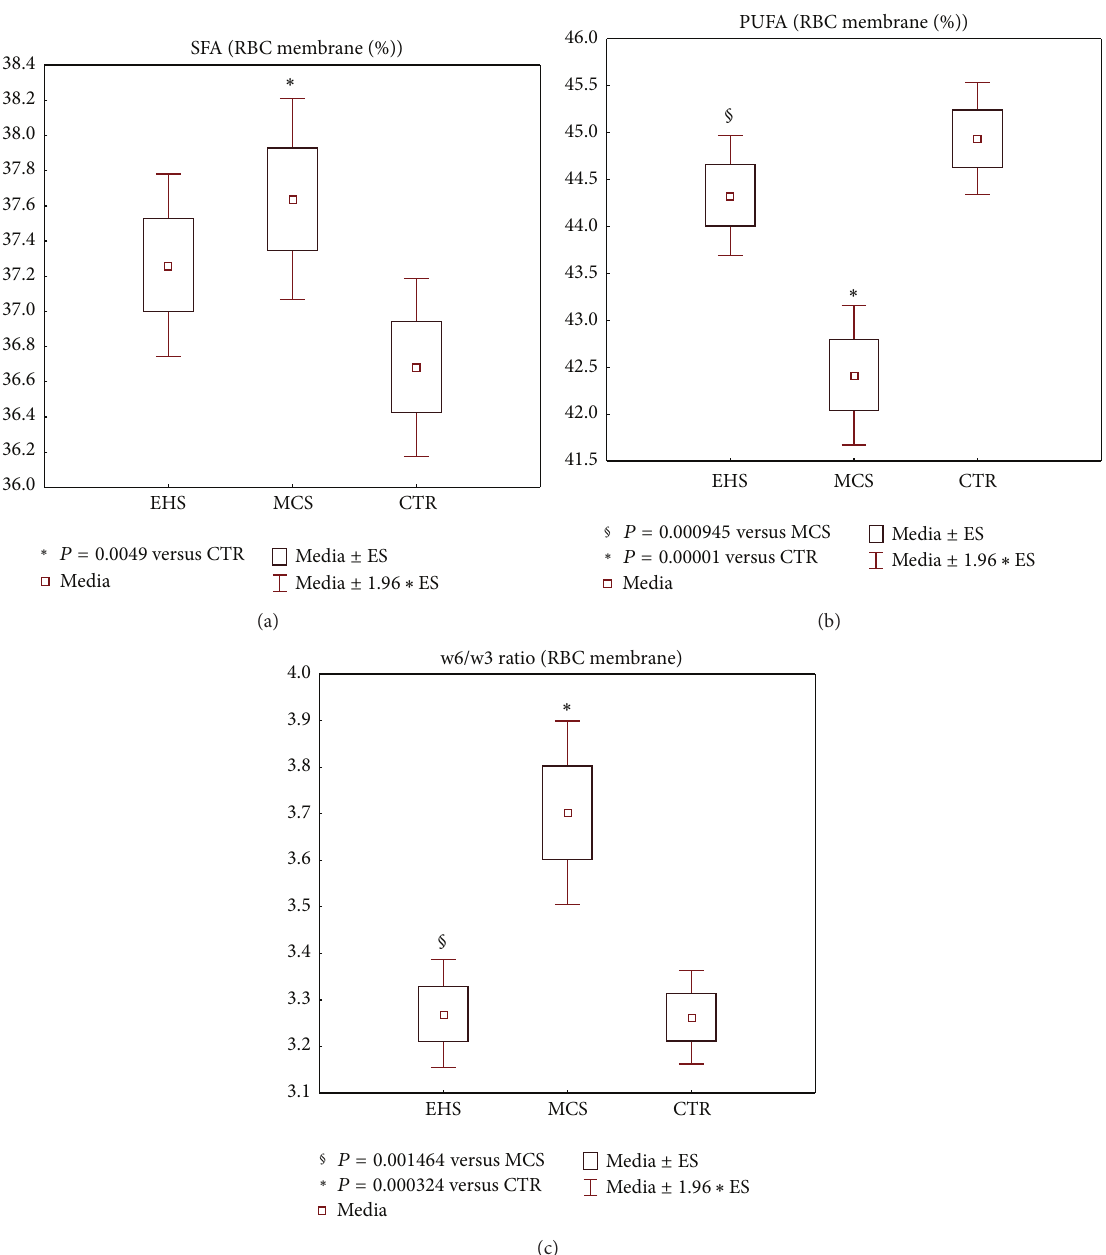
Figure 7: Selected representative parameters describing fatty acid (FA) patterns of erythrocyte membrane phospholipids, in the groups of patients self-reporting electromagnetic hypersensitivity (EHS, 𝑛 = 58 ), of patients affected by multiple chemical sensitivity without EHS symptoms (MCS, 𝑛 = 54 ), and of control healthy subjects (CTR, 𝑛 = 70 ). (a) % saturated and monounsaturated acid (SFA) on total FA content of phospholipids, (b) % polyunsaturated fatty acids (PUFA) on total FA content of phospholipids, and (c) ratio omega-6/omega3 PUFA. Values are represented as mean ( ◻ ), standard error of the mean (upper and lower limits of the box), and 1.96 × standard error (upper and lower whiskers). Intergroup significant differences ( P ) are reported under each panel. RBC: red blood